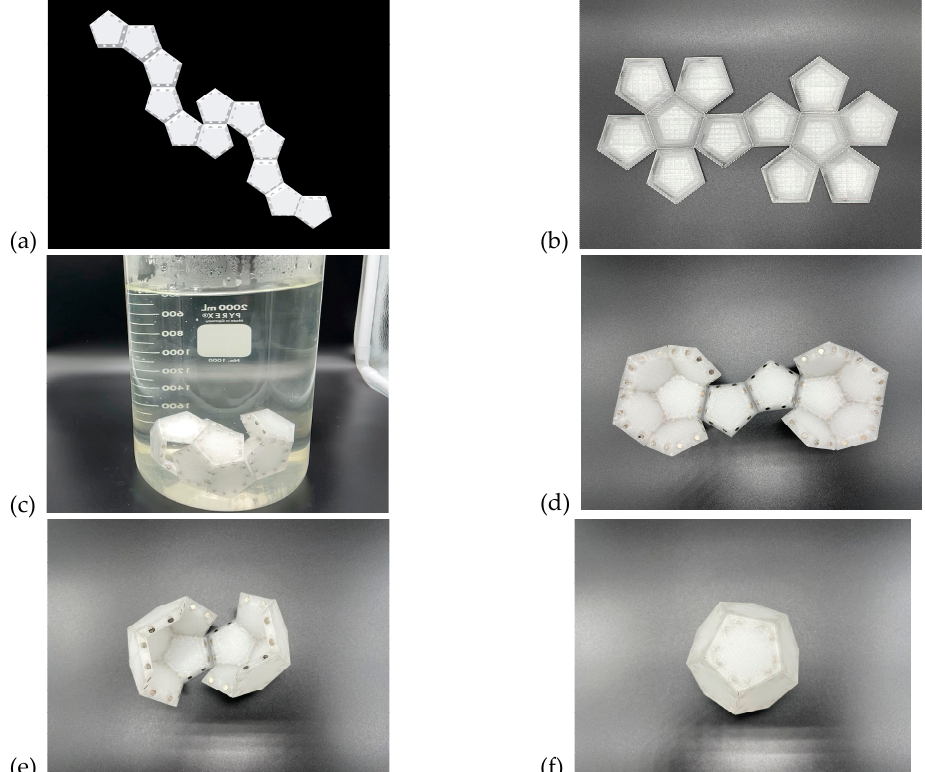
Figure 25. Two 3D-printed Dürer net of dodecahedra with flexible hinges for self-folding were chosen with 2-vertex connections ( a ) and 10-vertex connections ( b ), respectively. In ( c ) the Dürer net of a dodecahedron with 2-vertex connections did not fold successfully even when submerged in a warm water bath for an extended period of time. Supplemental Movie S2. On the other hand, consistent with our experience with “Radial Serial Folding” (Figure 6), the figures above ( d – f ) represent a correct assembly pathway and the one we observe when submerging the Dürer net of a dodecahedron with 10-vertex connections into a warm water bath. In the first figure ( d ) you can see that each of the leaves have folded first forming two almost complete halves of the dodecahedron. These fold first as there is less force required to lift a single leaf into position as compared to the other hinges. To complete the formation of the dodecahedron there are three edges that remain to be closed. If the two on the sides fold before the hinge in the middle the dodecahedron will correctly fold into its final shape. Supplemental Movie S3. In our experiments, these hinges do indeed fold before the middle hinge. An incorrect pathway occurs if the middle hinge closes before the two remaining that are to its left and right. In this case, the faces of the two halves of the dodecahedron would need to pass through each other to complete the folding procedure.